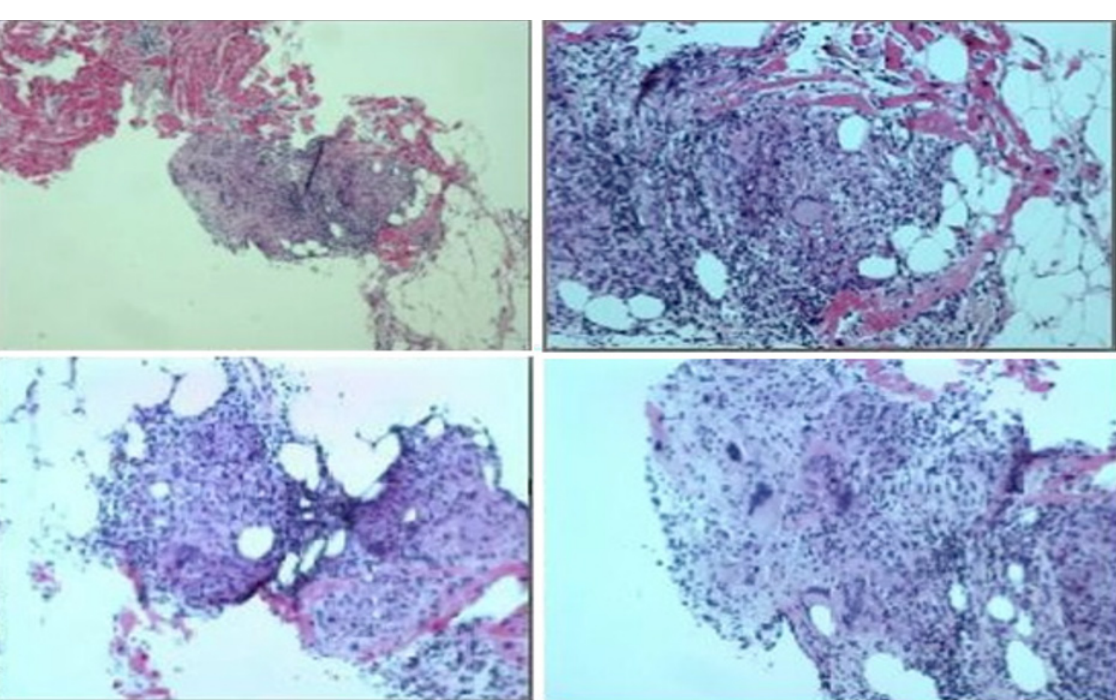
Figure 7. Endomyocardial biopsy demonstrates granulomatous infiltration of the myocardium. (hematoxylin-eosin staining, original magnification